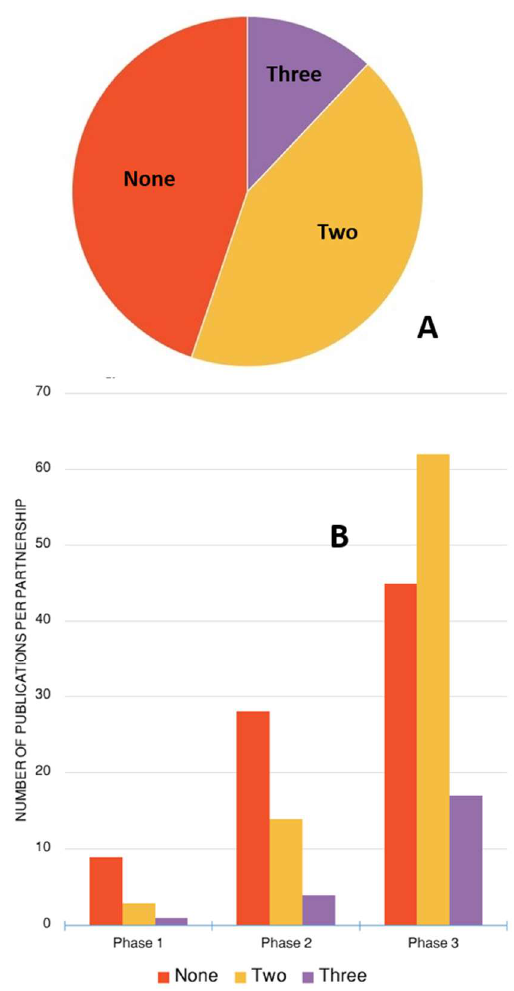
Figure 11. Qualitative and quantitative results of the institutional arrangements parameters. ( A ). Number of partnerships in each peer-reviewed publications between 1982 and 2016. ( B ). Number of partnerships over the 35-year period analyzed.